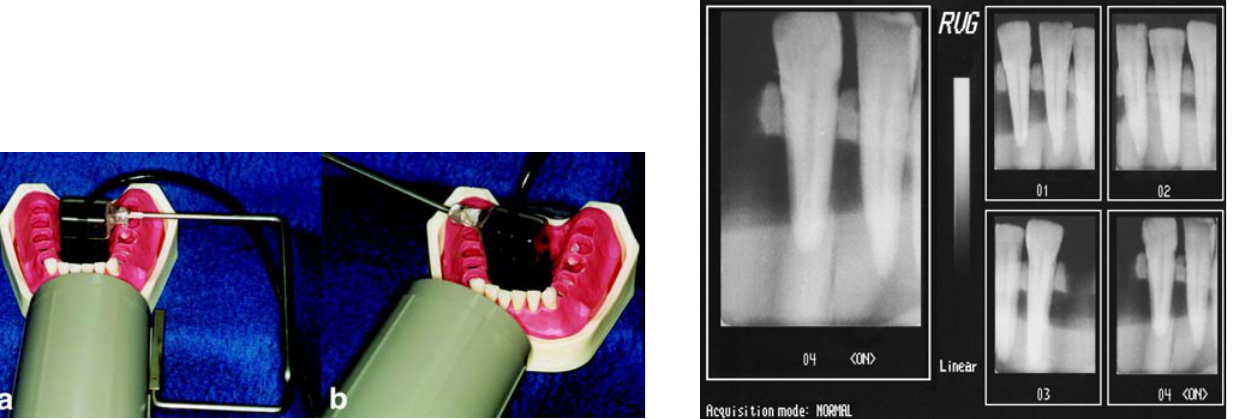
FIGURE 2- Examination (a - b) and images (c) in vitro : in BL direction with